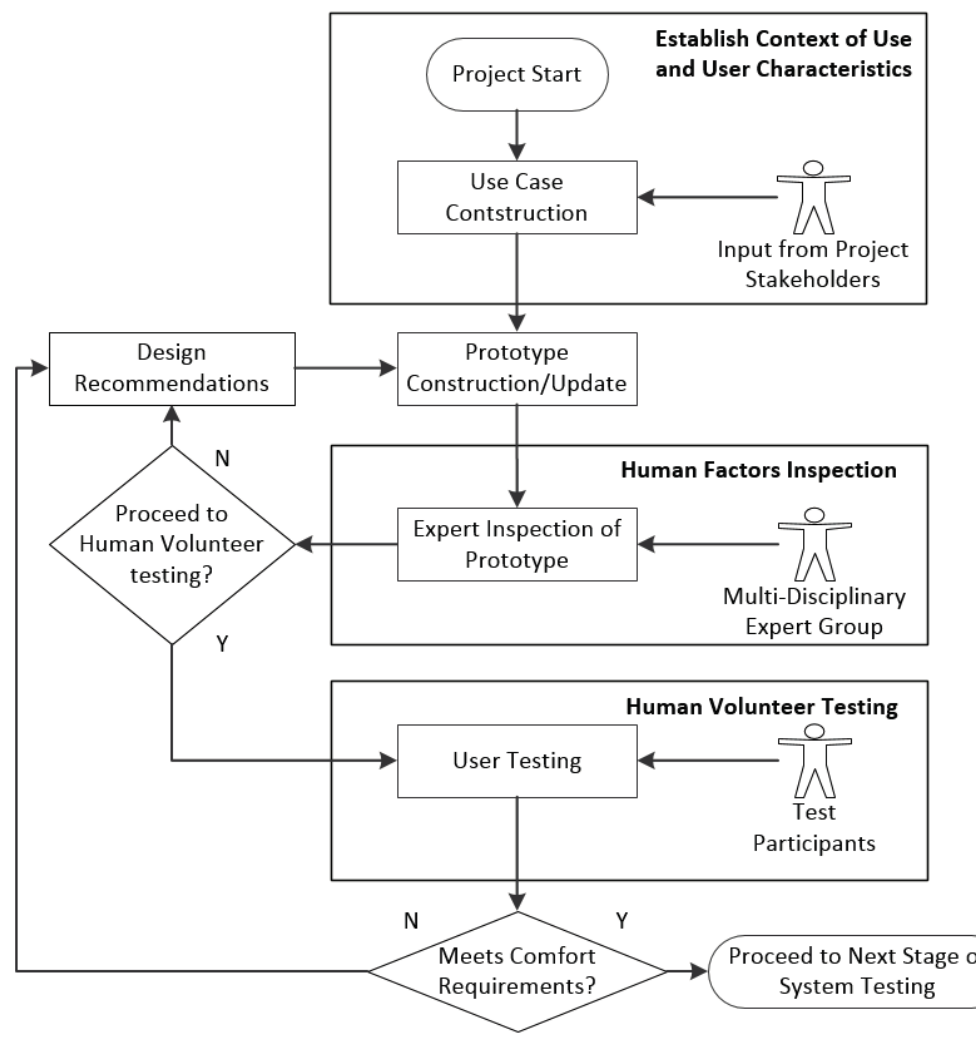
Figure 2. Iterative human factors and comfort assessment